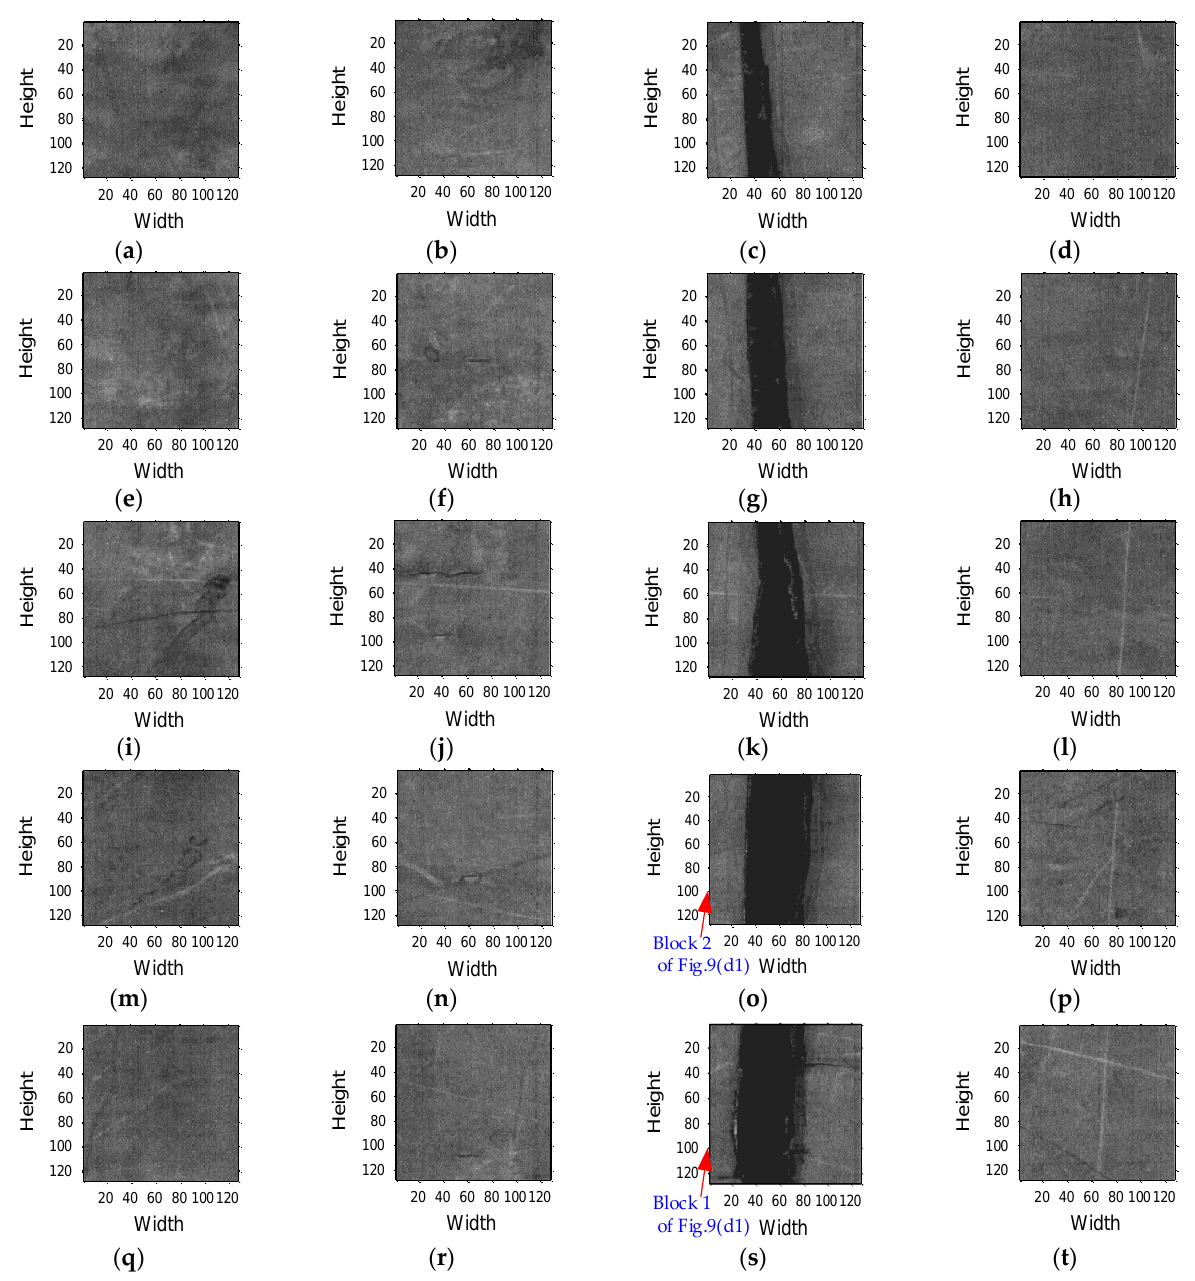
Figure 10. The result of 128 × 128 block for the ROI image extracted in Figure 9(d1). ( a ) (1,1). ( b ) (1,2). ( c ) (1,3). ( d ) (1,4). ( e ) (2,1). ( f ) (2,2). ( g ) (2,3). ( h ) (2,4). ( i ) (3,1). ( j ) (3,2). ( k ) (3,3). ( l ) (3,4). ( m ) (4,1). ( n ) (4,2). ( o ) (4,3). ( p ) (4,4). ( q ) (5,1). ( r ) (5,2). ( s ) (5,3). ( t ) (5,4).